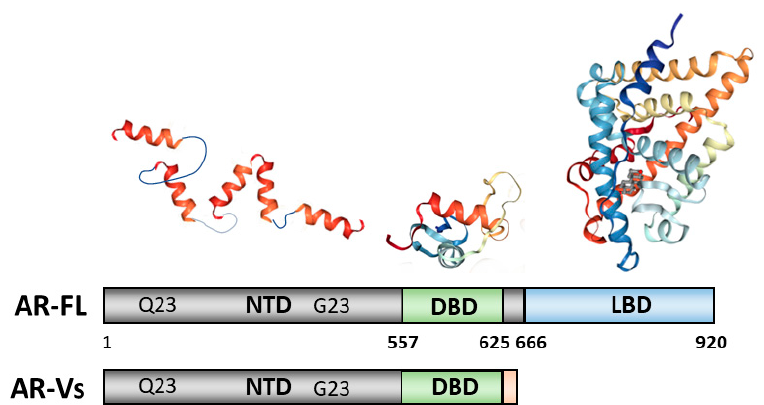
Figure 3. Functional and structural domains of the androgen receptor. The full-length androgen receptor (AR-FL) has a variable number of amino acids due to highly polymorphic glutamine (Q) and glycine (G) repeats in the amino-terminal domain (NTD). Splice variants (AR-Vs) lacking the ligand-binding domain (LBD), but retaining the DNA-binding domain (DBD) and NTD, are thought to emerge in PCa as a consequence of androgen ablation therapy. Available structural information for isolated ligand-binding (PDB 1I37) and DNA-binding (PBD 1R4I) domains is shown above the schematic of the AR-FL. Note—in the text the number of amino acids and point mutations is based on AR-FL of 920 amino acids.